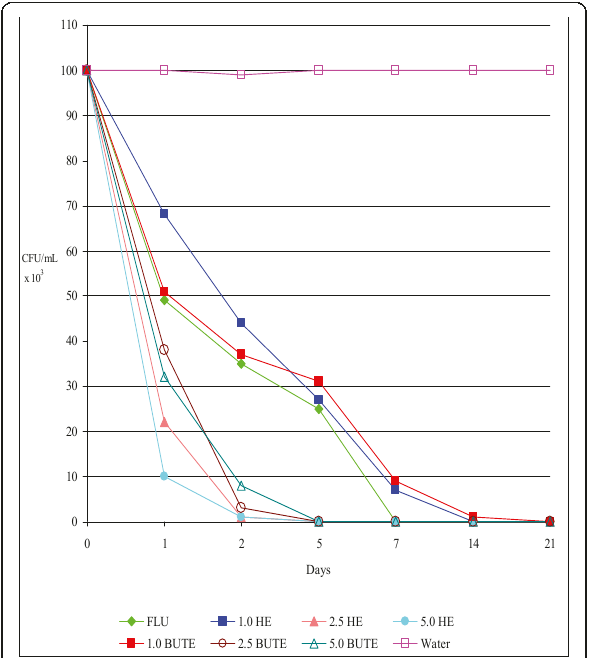
Figure 3 Colony-forming units (CFU/mL) of yeasts in the vaginal exudate of Wistar rats treated intravaginally with hydroalcoholic (HE) and butanolic (BUTE) extracts of Sapindus saponaria at 1.0%, 2.5%, and 5.0%, 100 μ g of fluconazole, or sterile distilled water at 1, 24, and 48 h after induction of the vaginal infection, followed for up to 21 days . Each curve represents the mean (± standard deviation) of the CFU of five rats, in two independent experiments. Experimental vaginal infection by C. glabrata resistant to itraconazole and fluconazole (RCG).